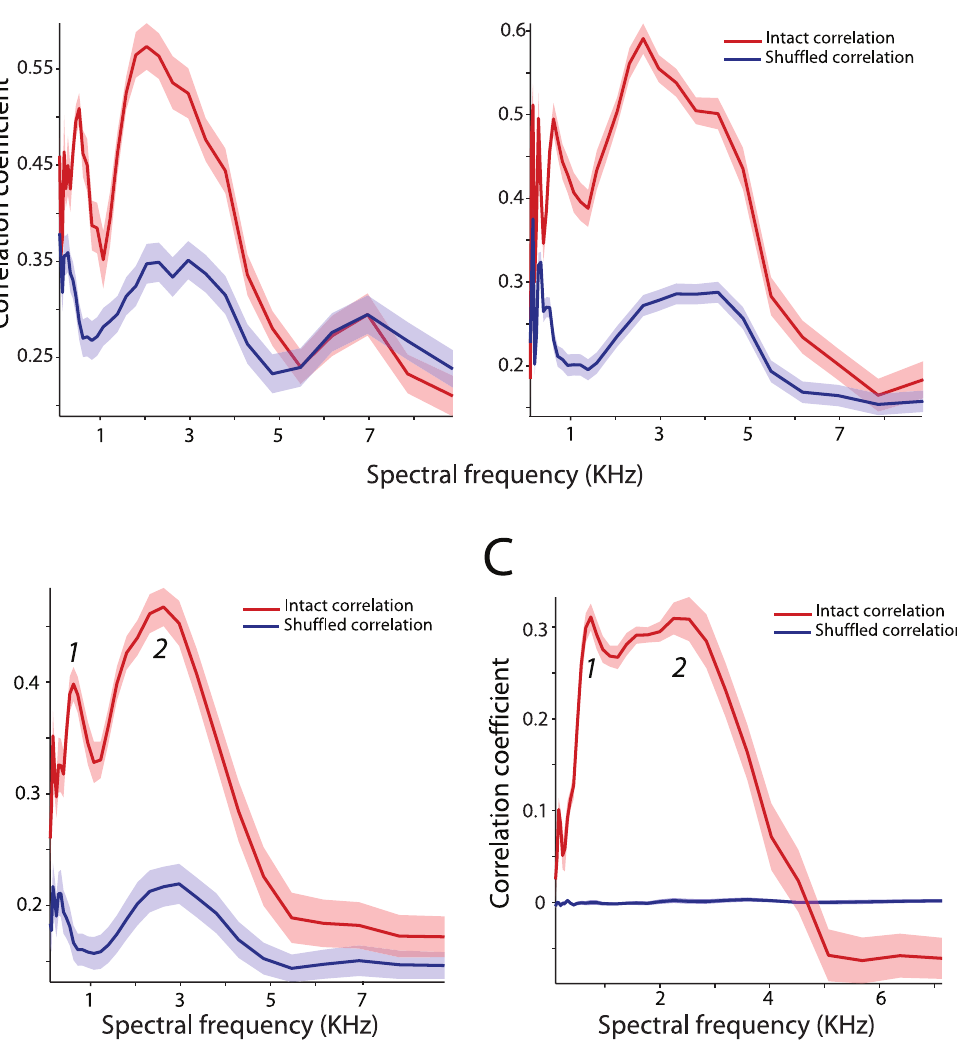
Figure 4. Correlation between visual and auditory components as a function of spectral frequency. A - Correlation coefficient between the area of the mouth opening and the envelope of each spectral band for two different subjects. X-axes depict the spectral frequency in KHz. Y-axes depict the correlation coefficient. The red line denotes the intact correlation between the area of the mouth opening and the auditory envelopes. Blue line denotes the average shuffled correlation for that subject. Shaded region denotes standard error of the mean. B - Average intact and shuffled correlation as a function of spectral frequency for the 20 subjects in the GRID corpus. Figure conventions are as in A. C - Average intact and shuffled correlation as a function of spectral frequency for the subjects from the Wisconsin X-ray database. Figure conventions as in